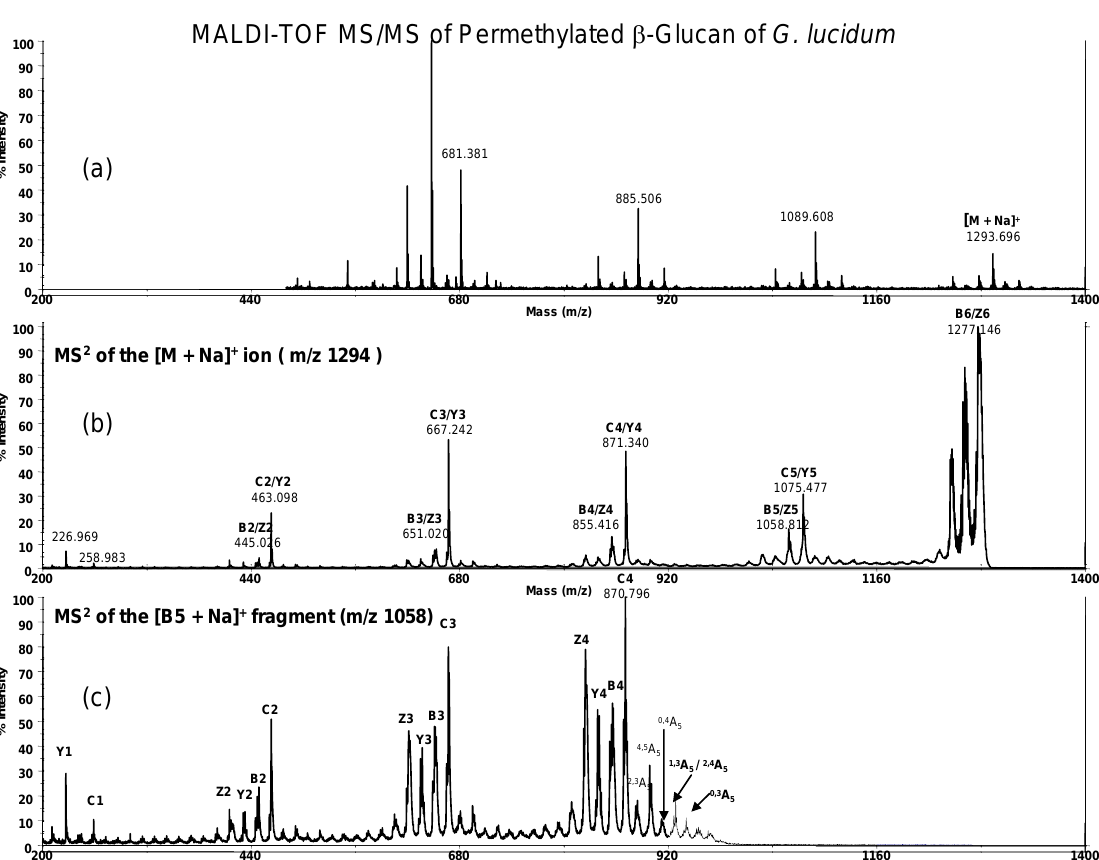
Figure 4 . MALDI-TOF MS/MS of permethylated G. lucidum glucans. The ion of permethylated G. lucidum hexasaccharide ( m/z = 1293.7, [M + Na] + ) shown in figure